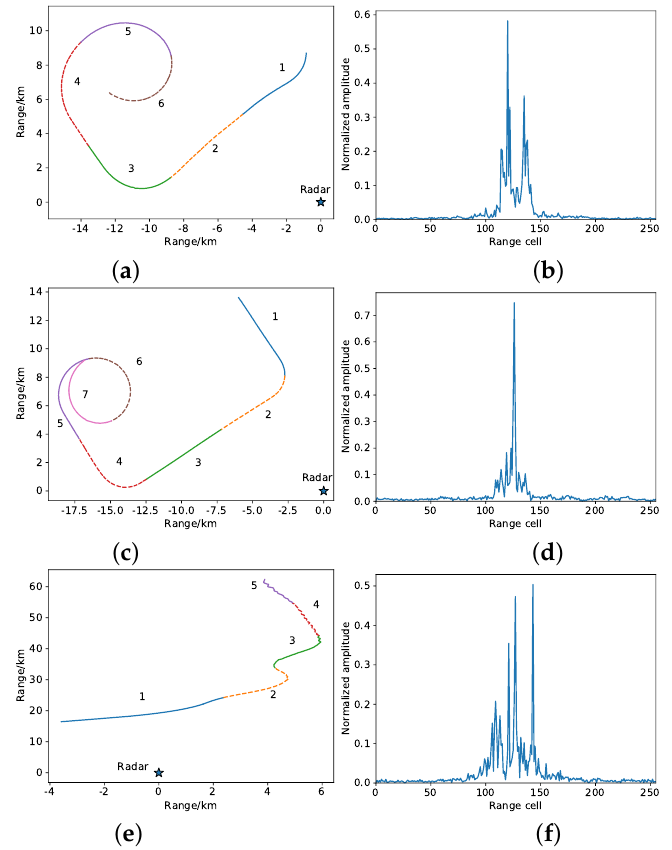
Figure 5. This figure shows the flight path and preprocessed HRRP of three airplanes. ( a ) An − 26; ( b ) An − 26; ( c ) Cessna; ( d ) Cessna; ( e ) Yak − 42; ( f ) Yak −